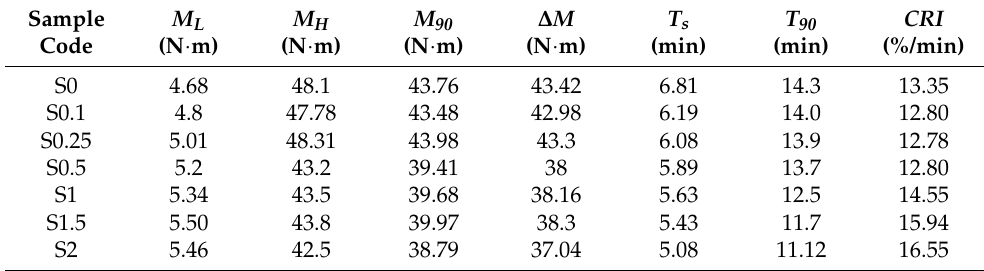
Table 2. Curing characteristics of NR/CNT/GNS hybrid nanocomposite foams at 155 ◦ C.